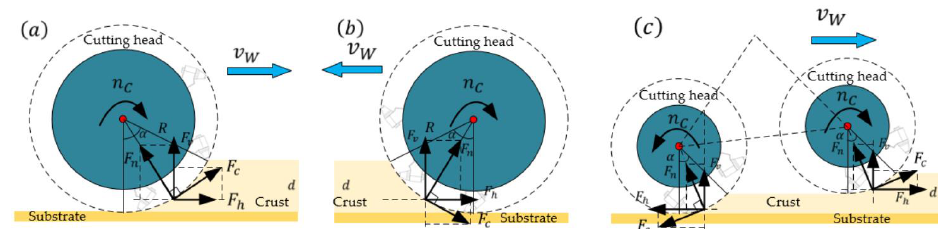
Figure 1. Cutting head structure ( a ) Down-milling, ( b ) Up-milling, ( c ) Dual drums.